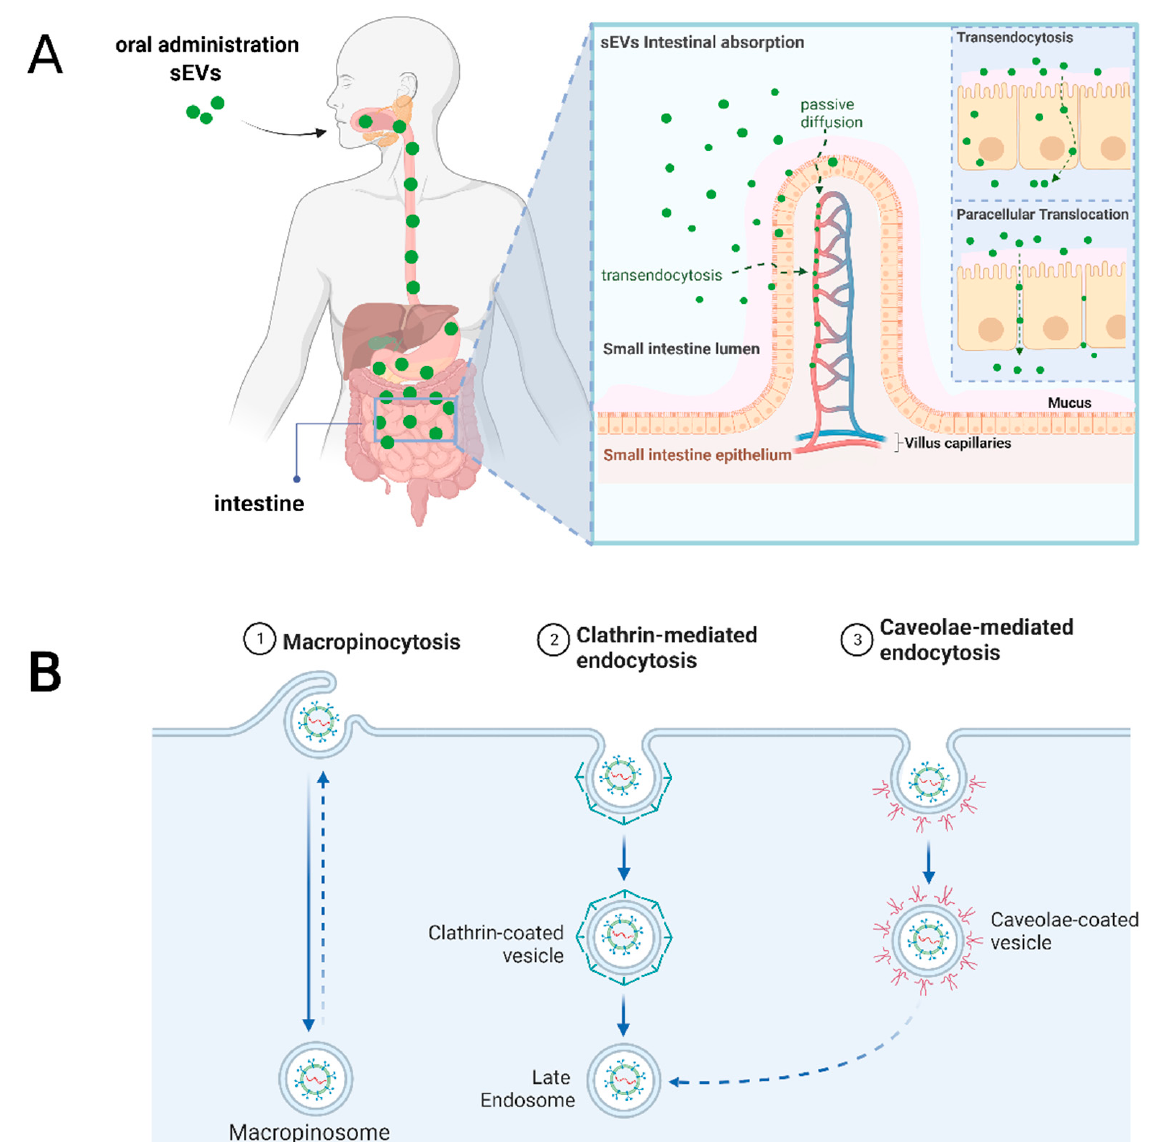
Figure 4. Scheme of the cellular mechanisms of absorption in the gastrointestinal tract of orally administered sEVs. ( A ) After oral intake, sEVs can resist the hostile degradative environment of the gastrointestinal tract and reach the intestine. At this site, the absorption of sEVs or their transport into the systemic circulation would occur, overcoming the cell permeability barrier. This figure was constructed based on preclinical in vivo/in vitro revised data and is a theorical extrapolation of what is expected in human. ( B ) In vitro studies demonstrate that multiple endocytic pathways are involved, including caveola- and clathrin-mediated pathways and macropinocytosis. Additionally, it has been described that sEVs could cross the intestinal epithelium through the intercellular spaces between epithelial cells, passively transported from the intestinal lumen to the circulation in a mechanism called paracellular translocation (created with http://www.biorender.com (accessed on 24 November 2022)).